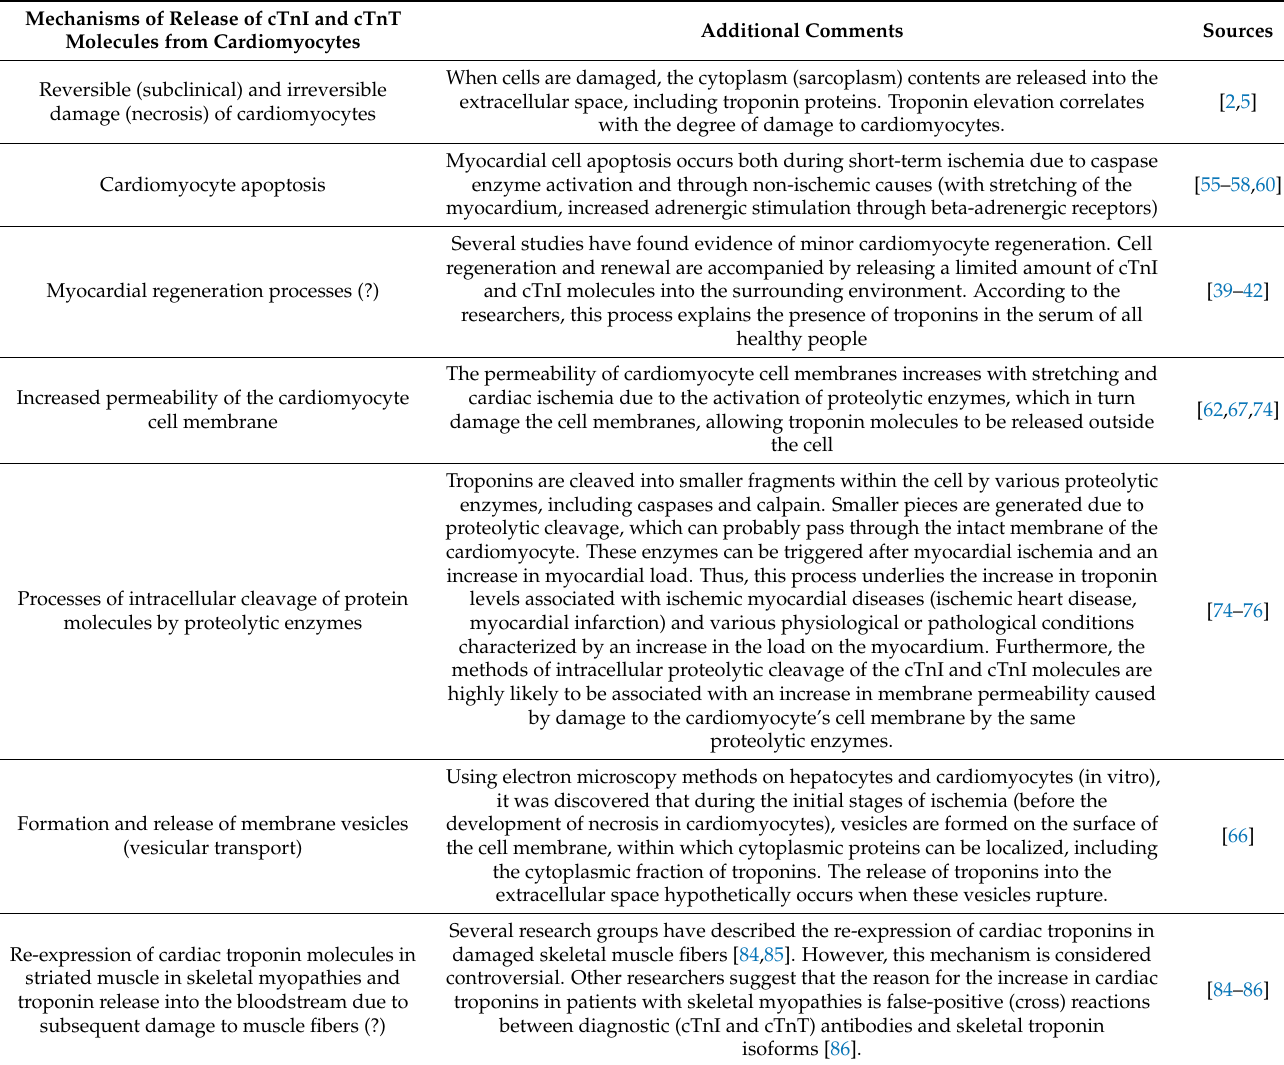
Table 1. Mechanisms of cell release/increasing troponin cTnI and cTnT